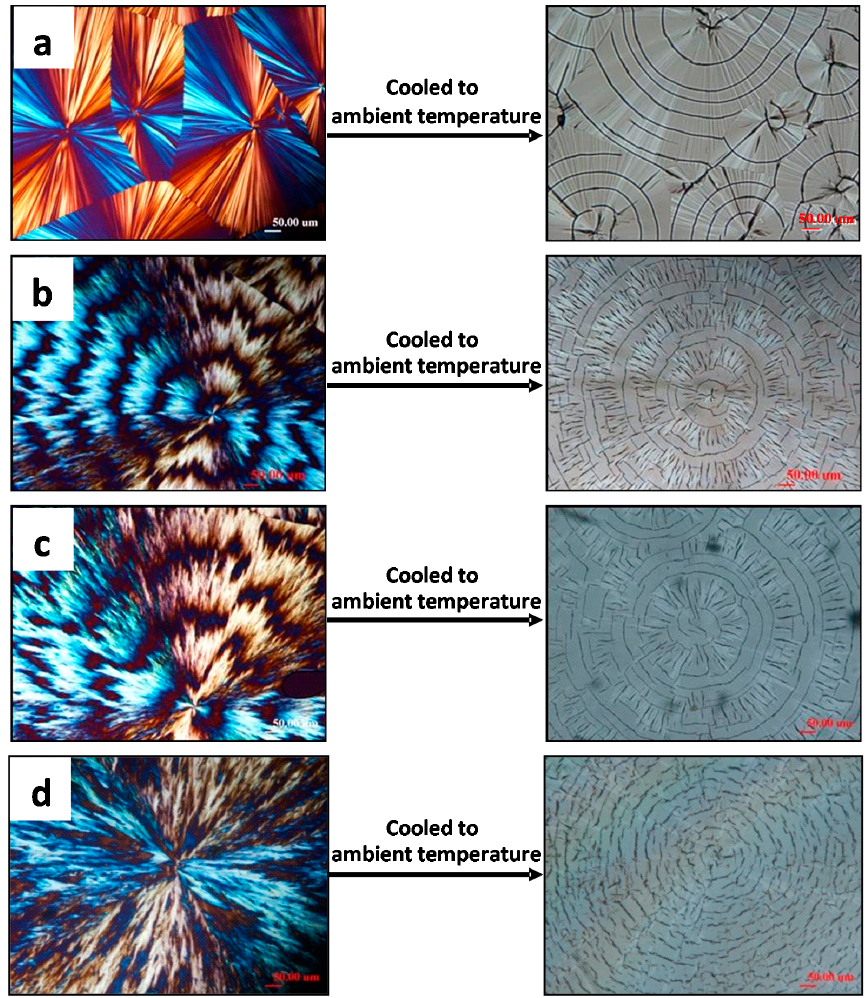
Figure 2. Cracks upon cooling from T c as revealed in optical microscopy morphology of PLLA spherulites crystallized with a top cover at T c : ( a ) 120 °C; ( b ) 125 °C; ( c ) 130 °C; and ( d ) 135 °C. Reproduced from Ref. [29] with permission from Springer (scale bar = 50 μ m in all graphs).